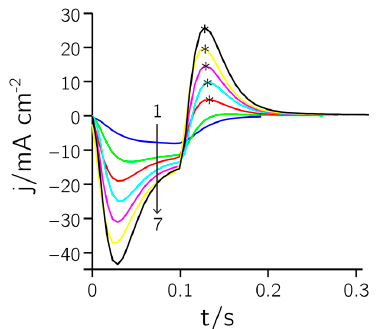
Figure 2. Deposition of Pt black. The curves marked 1 to 7 show the current density versus time response of every 13th pulse as recorded during the deposition procedure (t on = 0.1 s, E on = 0 V, t off = 0.4 s, E off = 0.68 V, 160 cycles). The asterisks indicate the current density peak values for charging the double layer capacitance.